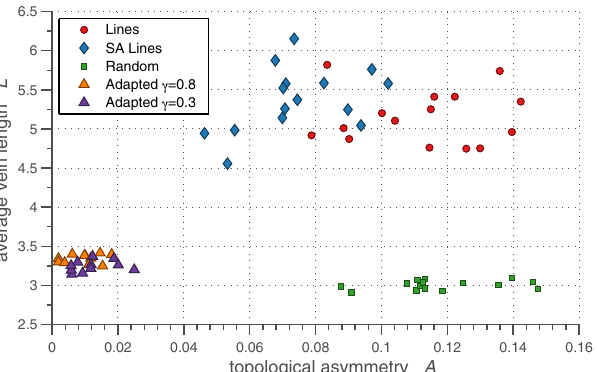
FIG. 11. Average vein length versus topological asymmetry for various edge-weight assignment models on random 3-regular graph topologies. The number of nodes on each graph was approximately N ≃ 500 . Blue: SA lines; red: lines; green: random; orange: adapted 0.8; and purple: adapted 0.5.